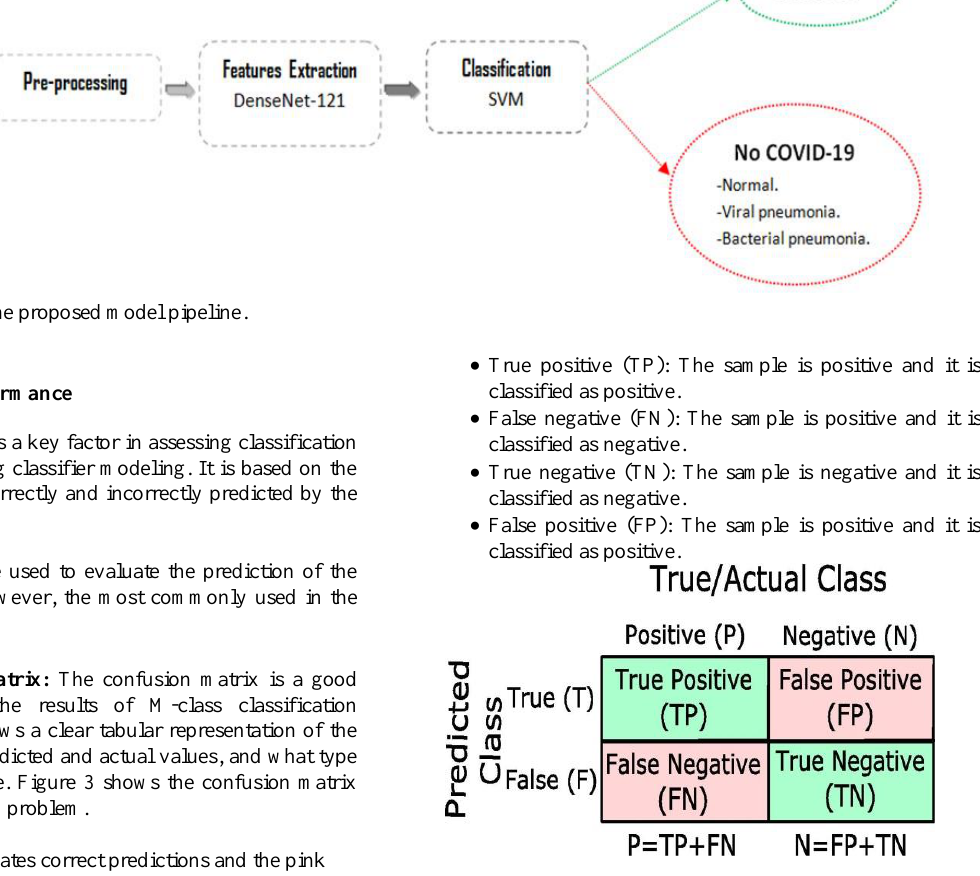
Figure 3. Confusion matrix in a 2-class